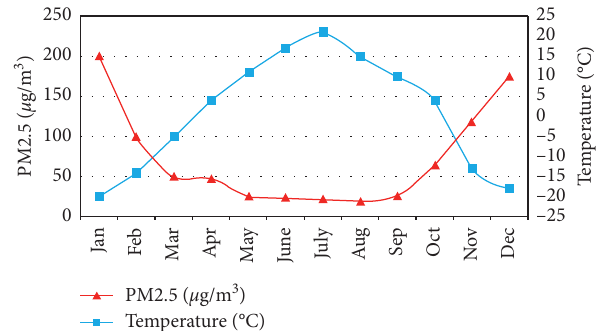
Figure 1: Monthly variation of PM 2.5 levels and